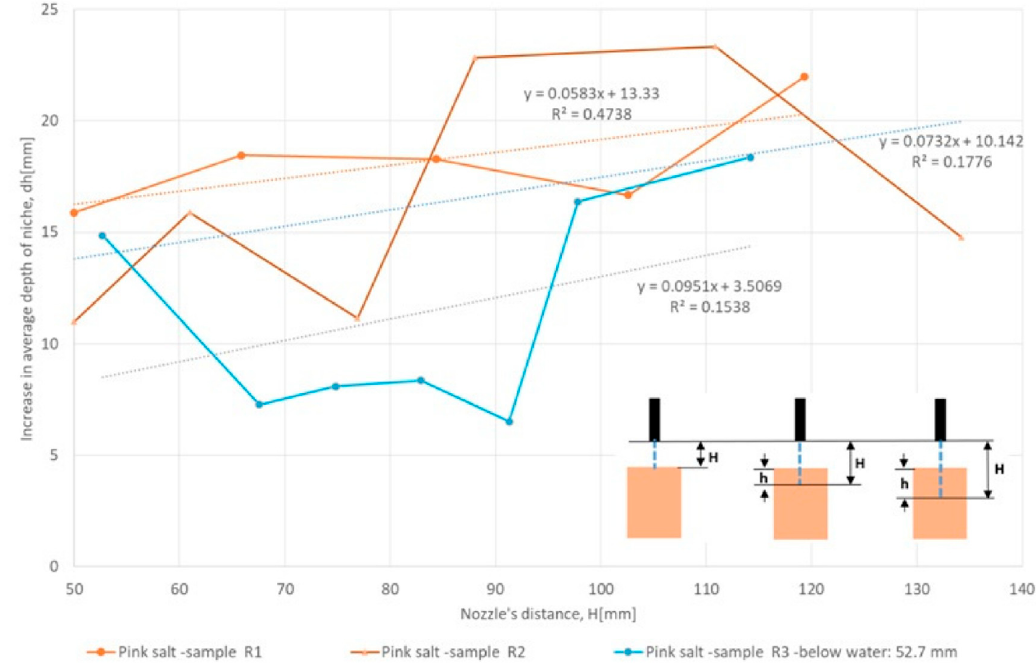
Figure 12. Dependence of the nozzle’s distance from the salt contact surface and average increases in niche depth after one cycle. Nozzle’s displacement velocity v = 100 (mm/min). Water jet pressure p = 500 bar.